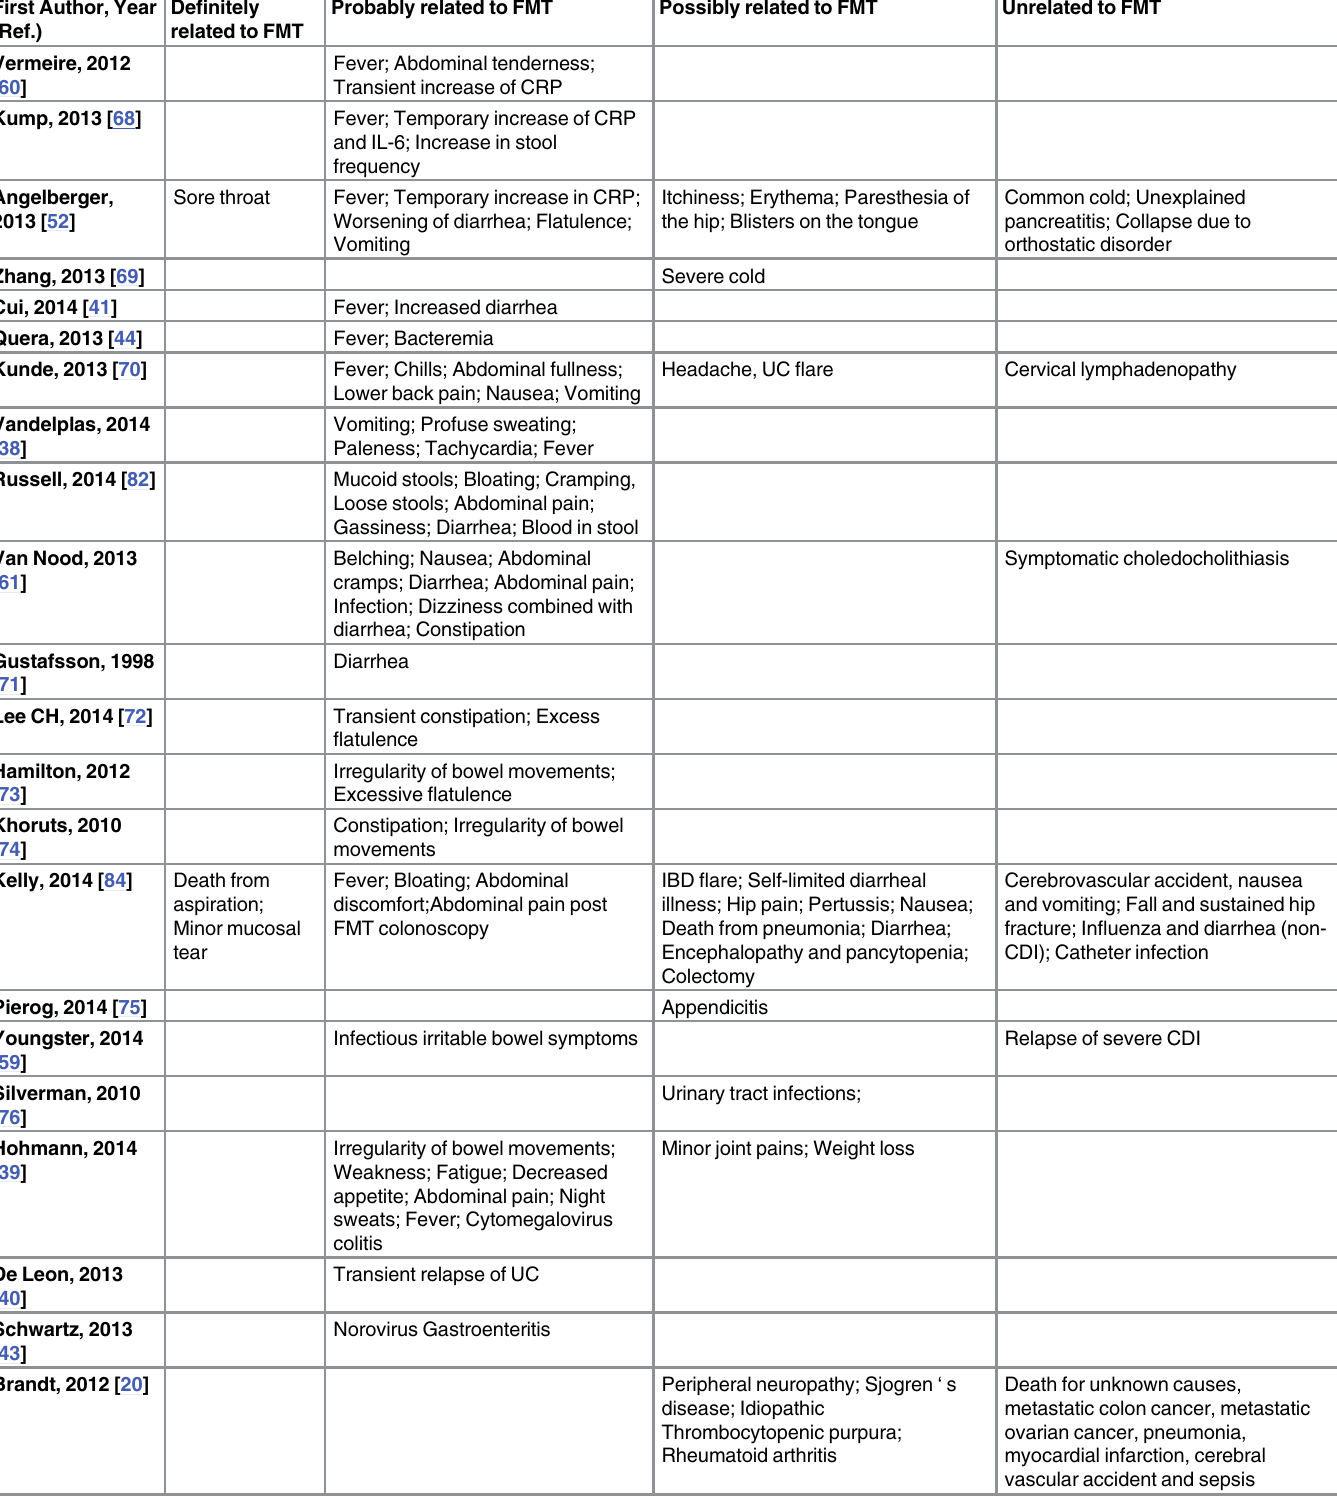
Table 4. Adverse events are grouped by their causality with fecal microbiota transplantation. First Author, Year